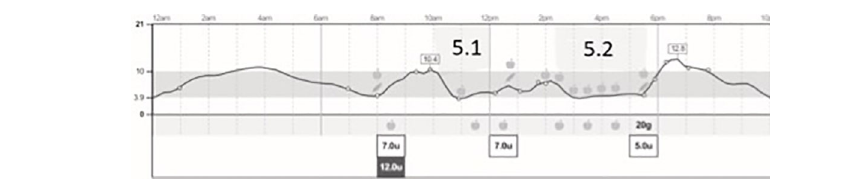
FIGURE 2 Glucose trace from swim